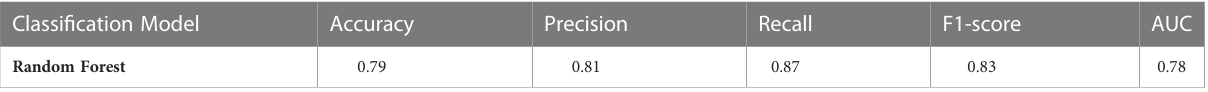
TABLE 1 The performance of Random Forest model to predict susceptible groups of in fl uenza A/H3N2. Classi fi cation Model Accuracy Precision Recall F1-score AUC Random